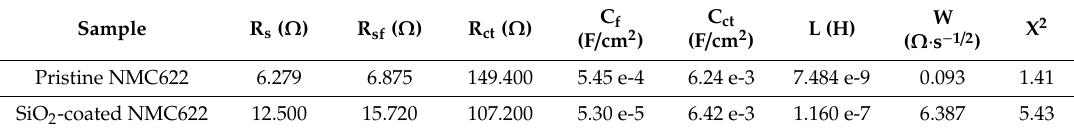
Figure 7. EIS measurements of the pristine and SiO 2 -coated NMC622: ( a ) Nyquist plots of both samples after 700 cycles and the fitting results; ( b ) the applied equivalent circuit model [17]. Table 3. EIS fitting results of the pristine and the SiO 2 -coated NMC622 after 700 cycles.